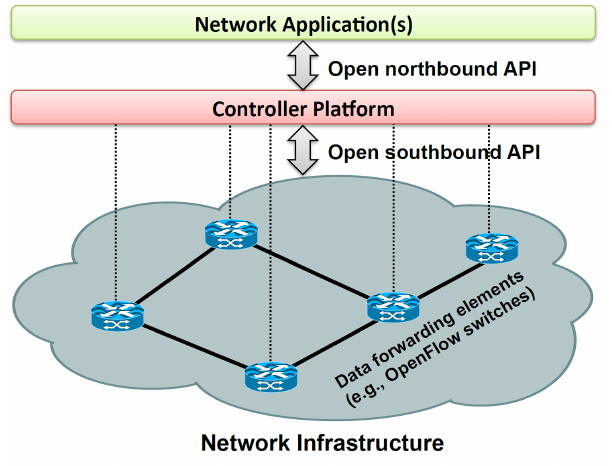
Figure 1. SDN architecture. Retrieved from